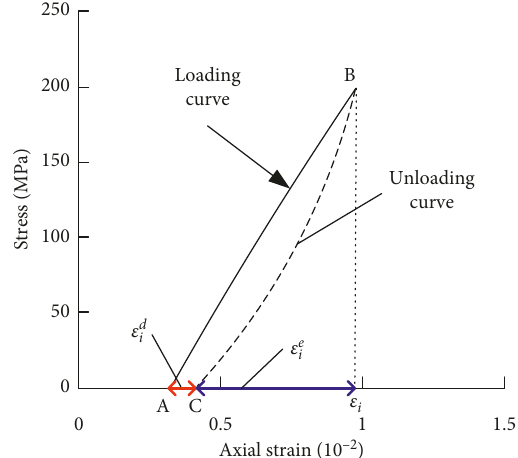
Figure 5: Relationship among the TAE, the ESE, and the DE during the i -th loading-unloading.